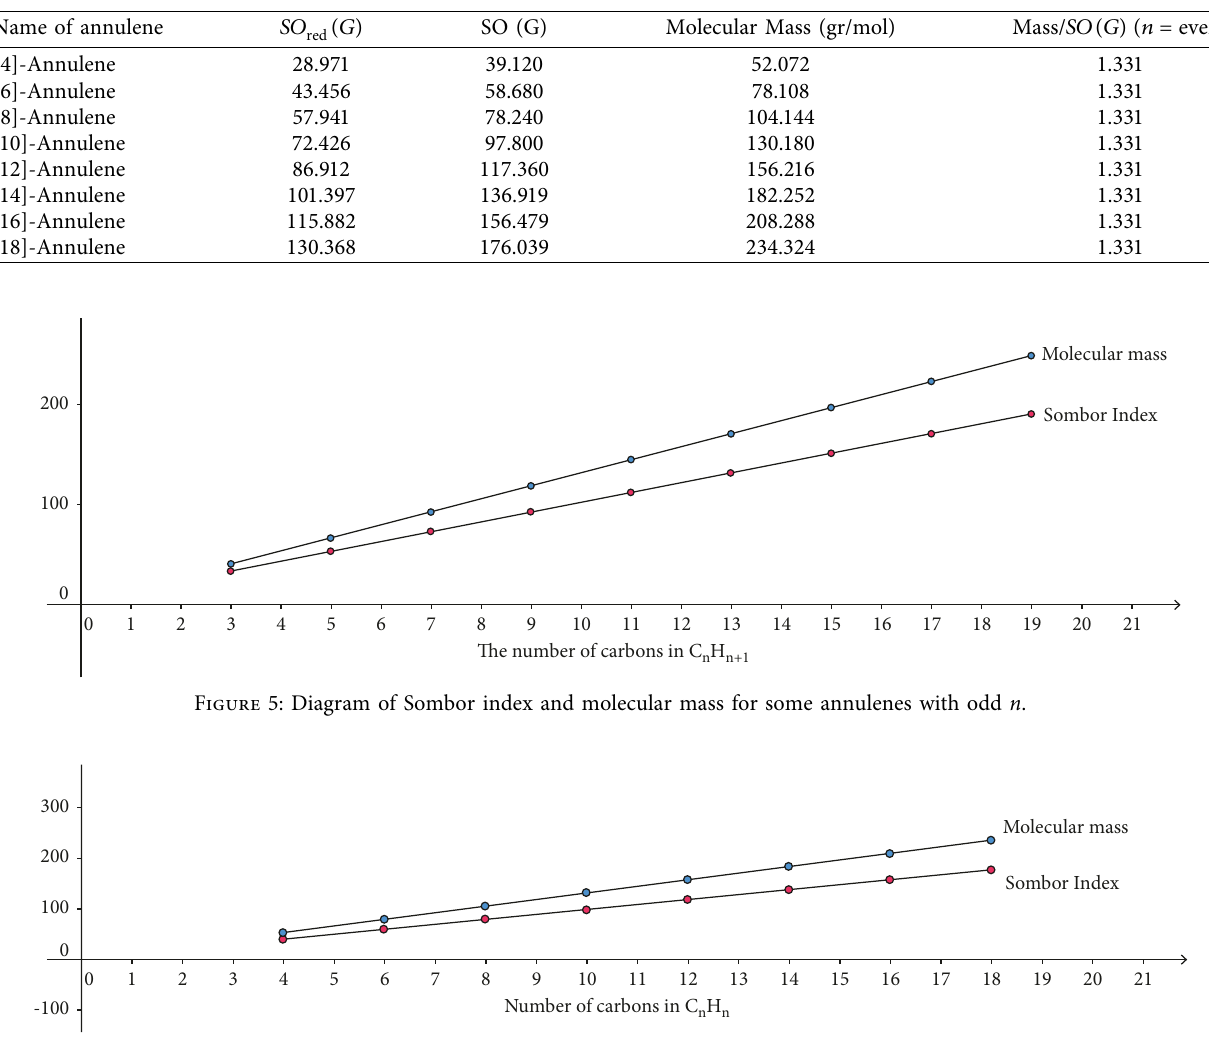
Table 4: Sombor index and molecular mass of some annulenes ( n � even ≥ 4).